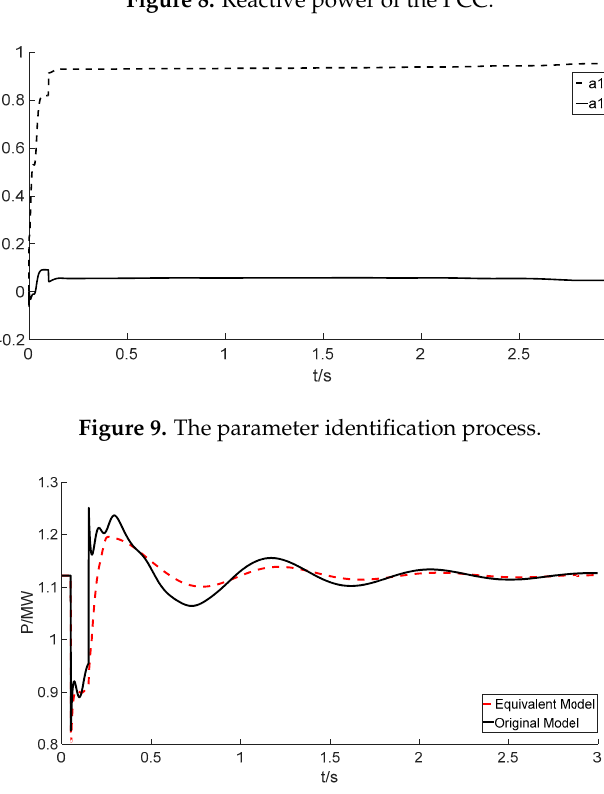
Figure 8. Reactive power of the PCC.